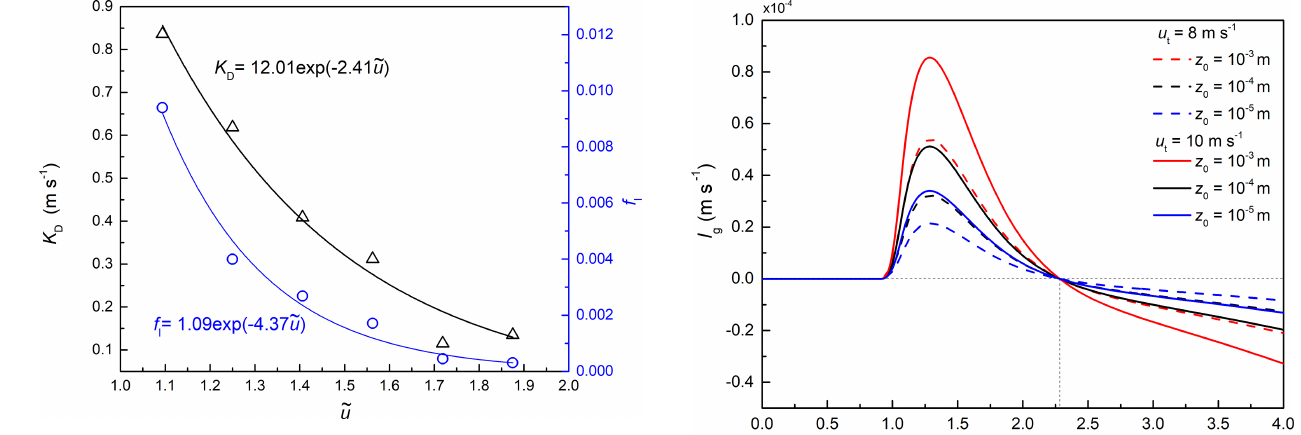
Figure 8. Deposition coefficient and the horizontal collection rate in all wind conditions. The solid lines are the fit curves.